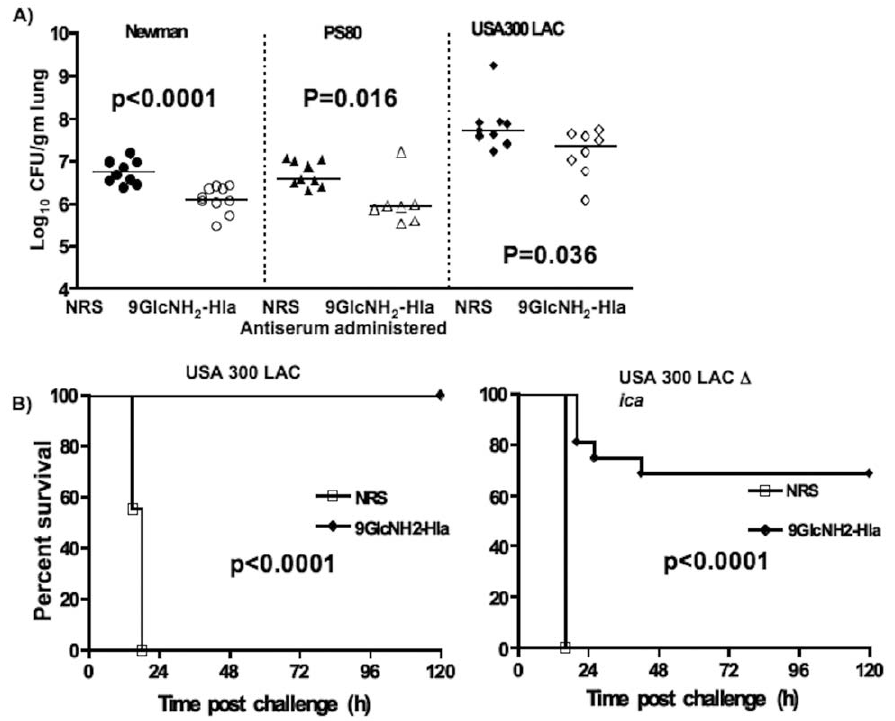
Figure 4. Passive immunization with 9GlcNH 2 -Hla antibodies in a murine model of S.aureus pneumonia. (a) Mice were vaccinated i.n with 20 m l of 9GlcNH 2 -Hla antisera or NRS 24 h and 4 h prior to infection with indicated S. aureus strains (4 6 10 8 CFU/mouse). Bacterial burden was recorded 24 h post-infection. Points indicate cfu/lung of individual mice, lines the group median; p values: Mann-Whitney test. (b) Kaplan–Meier survival curve of 4 week old FVB mice vaccinated i.n with 20 m l of 9GlcNH 2 -Hla antisera or NRS 24 h and 4 h prior to infection with indicated S. aureus strains (6 6 10 8 CFU/mouse). Survival was monitored at least twice a day over a 5 day period and data analyzed using the Log-rank test to derive the p